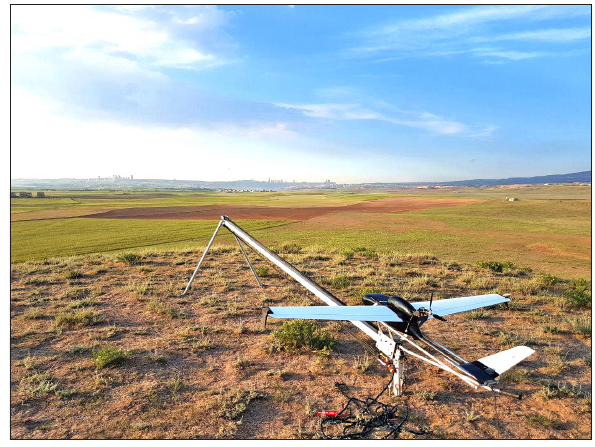
Figure 1. “Cetus” UAV prepared for take-off The UAV body is made of durable fiberglass and car- bon fiber, resistant to external influences, and rubber dampers are used to reduce impact loads during landing.